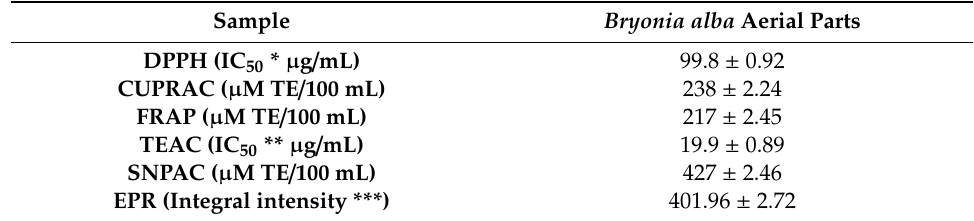
Table 3. Assessment of the antioxidant capacity of the aerial parts of Bryonia alba L. (IC 50 µ g / mL or µ M TE / 100